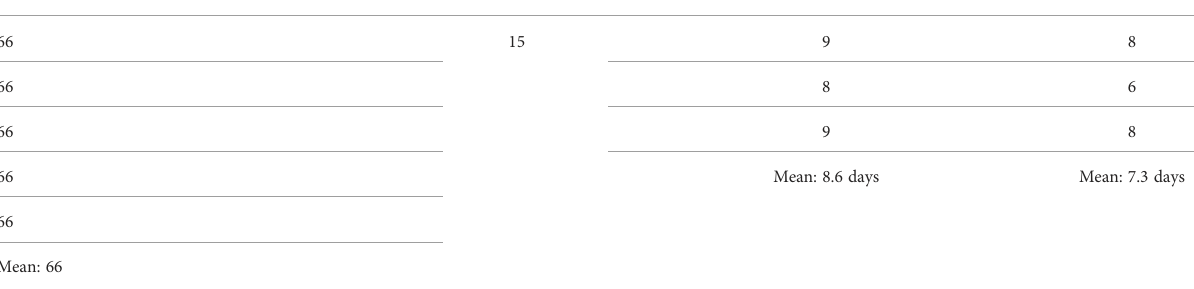
TABLE 2 Survival time of each group including the one for the “ positive fail pig ” . Group 1 (treated with 166 Ho). n = 5 minipigs Positive fail pig Group 2 (injected with 165 Ho). n = 3 minipigs Control